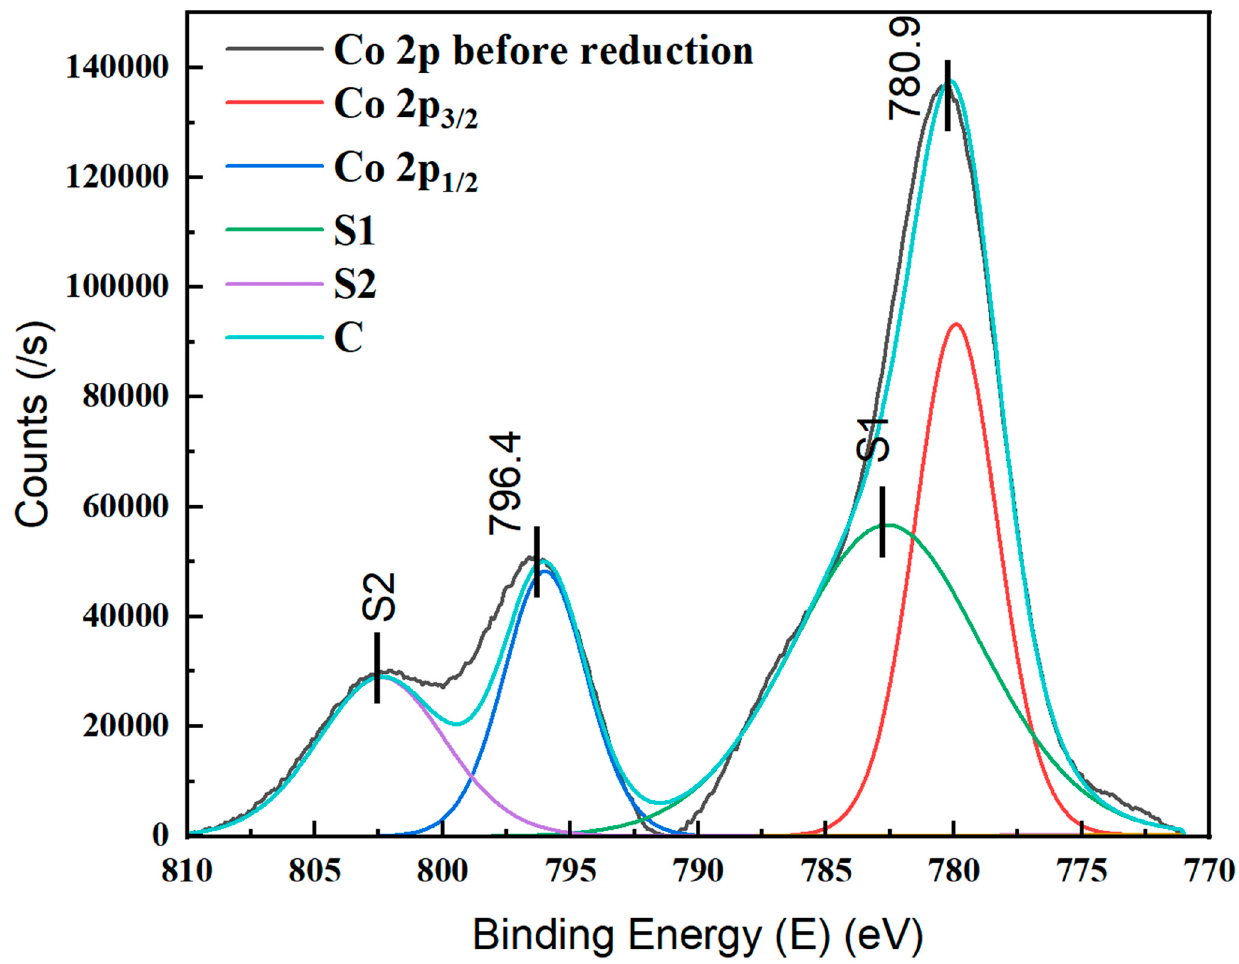
Figure 6. XPS spectra of as-deposited cobalt oxide film by ALD on silicon microreactor .